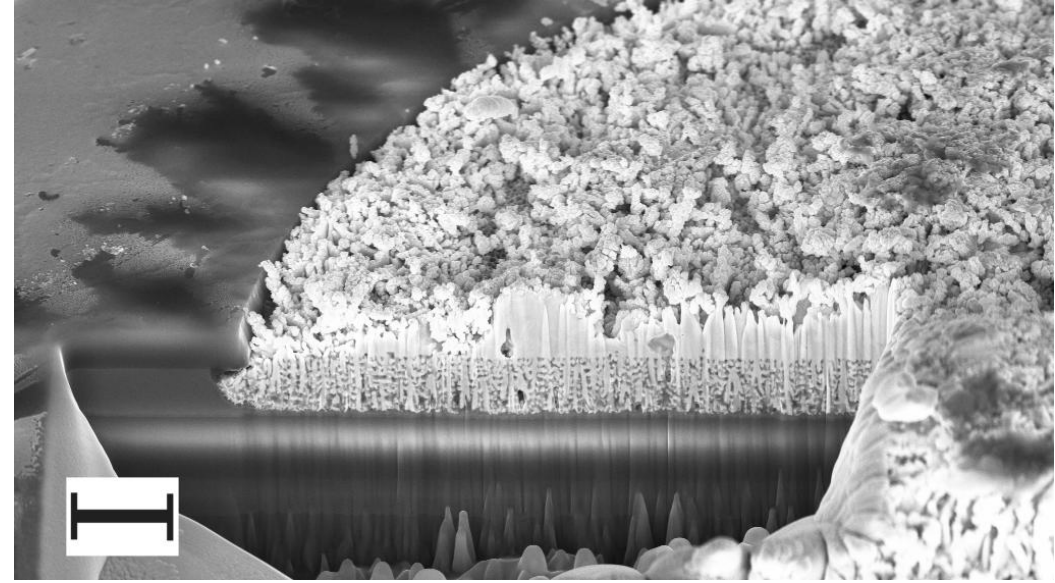
Figure 8. Porous alumina and gold CMOS electrode after deposition of platinum black at 50 mA∙cm −2 . The platinum is within the defined pad area and is flush with the passivation surface. Scale bar is 2